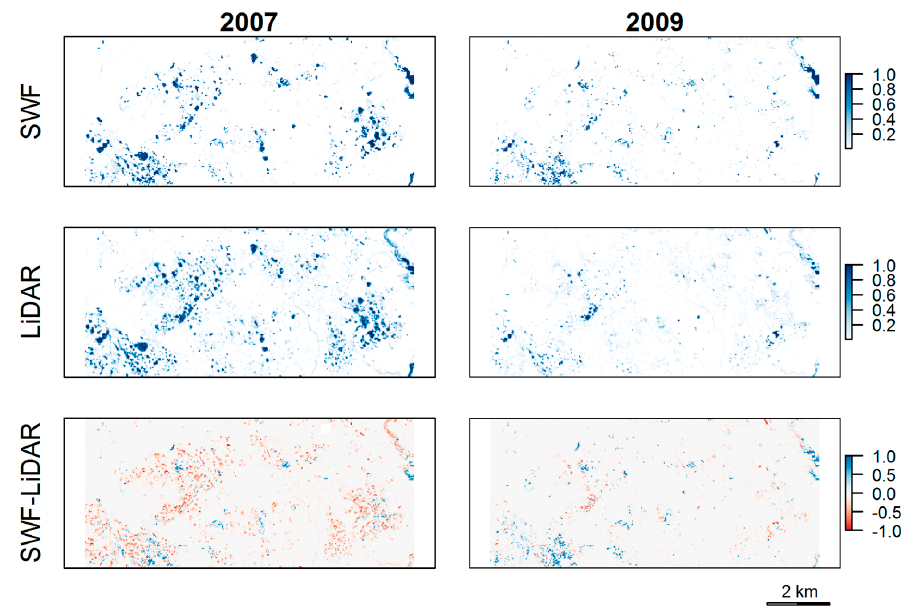
Figure 5. Comparison of automated SWF estimates (top row) with SWF derived from gridded LiDAR data over a forested wetland in the Delmarva Peninsula for two scenes in spring 2007 (left column) and 2009 (right column). The difference between automated SWF and LiDAR estimates is shown in the bottom row.